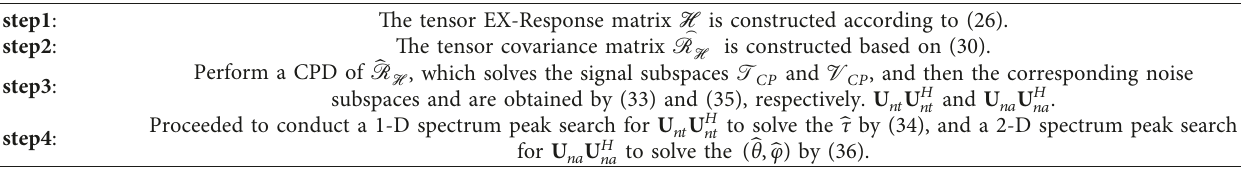
Table 2: Algorithm